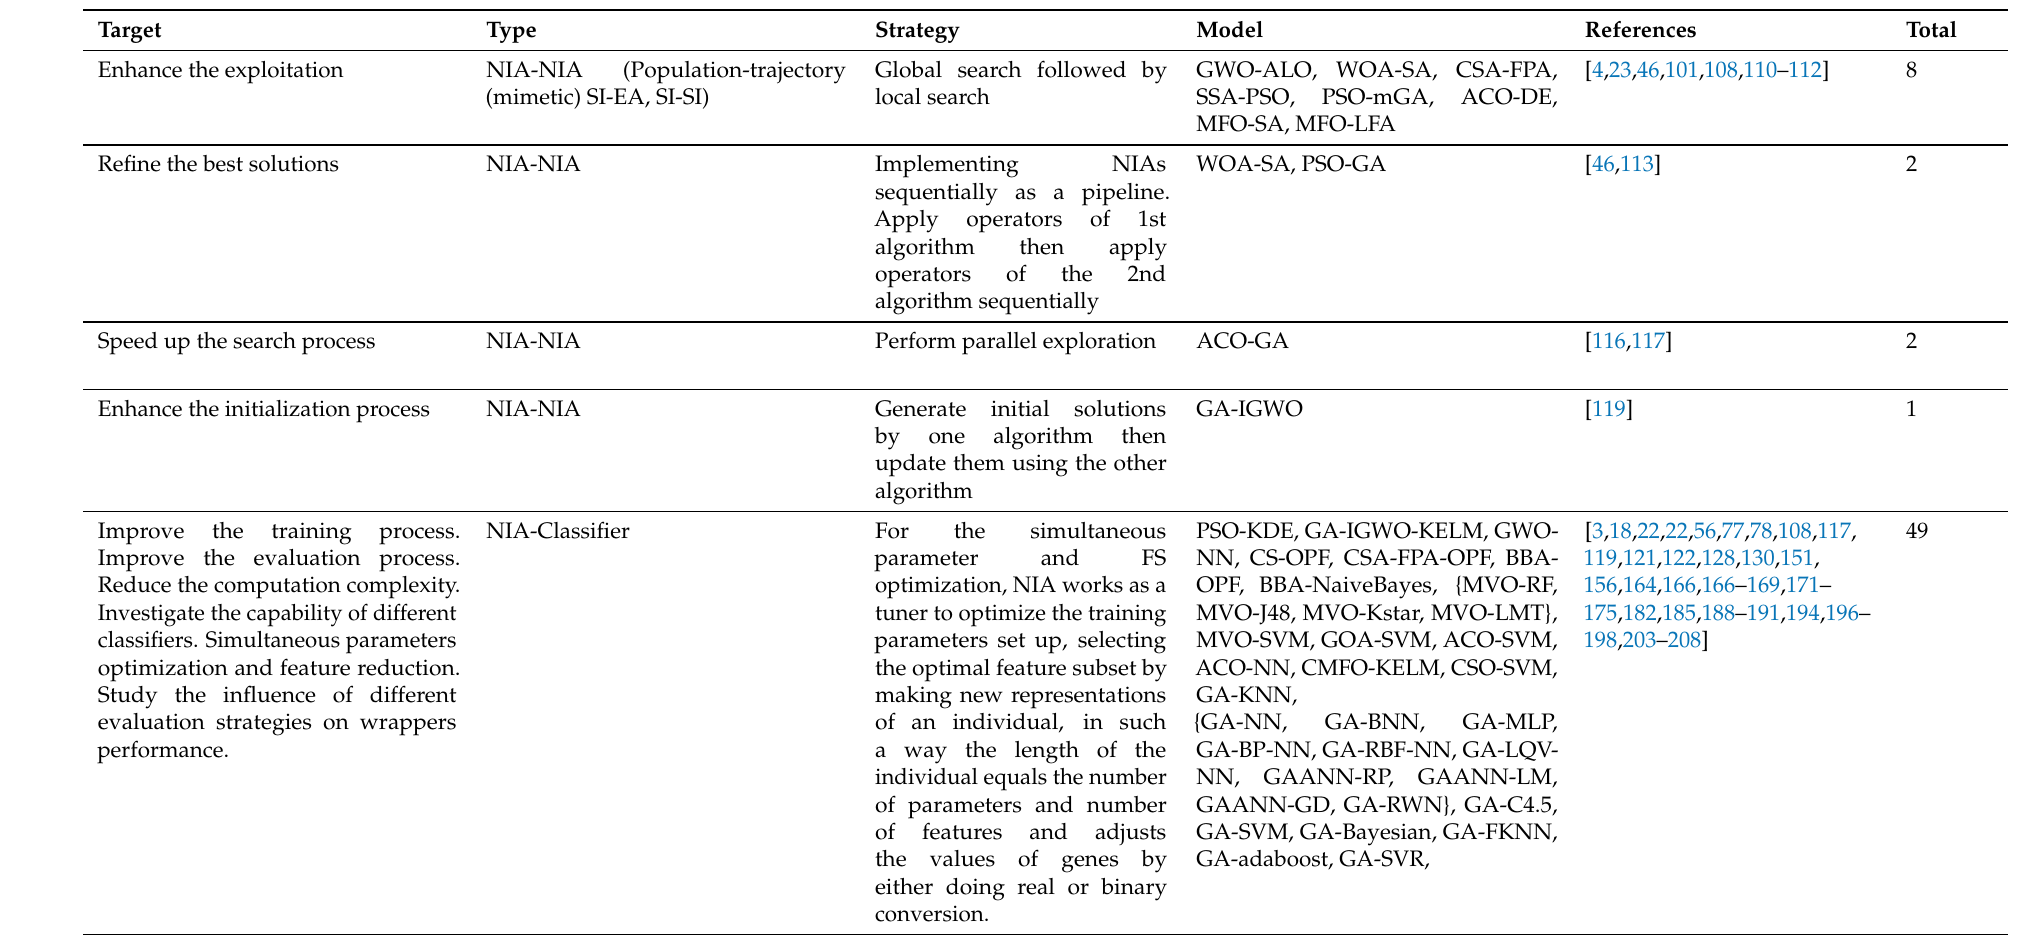
Table 2. Summary of main studies in the literature that adopted hybridization modification technique for